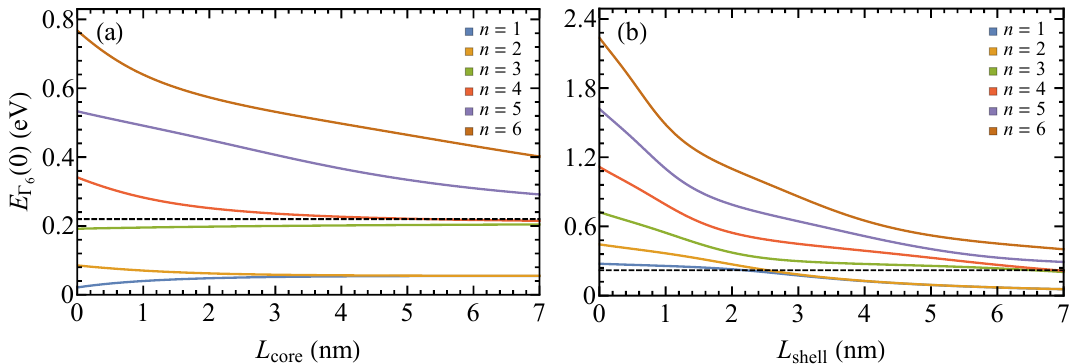
( k = 0 ) of the first six subbands of CdTe/ZnSe/CdTe nanoplatelets as functions Figure 3. Energies E Γ 6 of ( a ) core thickness L core for L shell = 7 nm and ( b ) shell layer thickness L shell for L core = 7 nm. The energy is measured from the bottom of the conduction band of bulk CdTe; dashed line is the barrier energy ∆ E 0 Γ . The material parameters are the same as in Figure 6